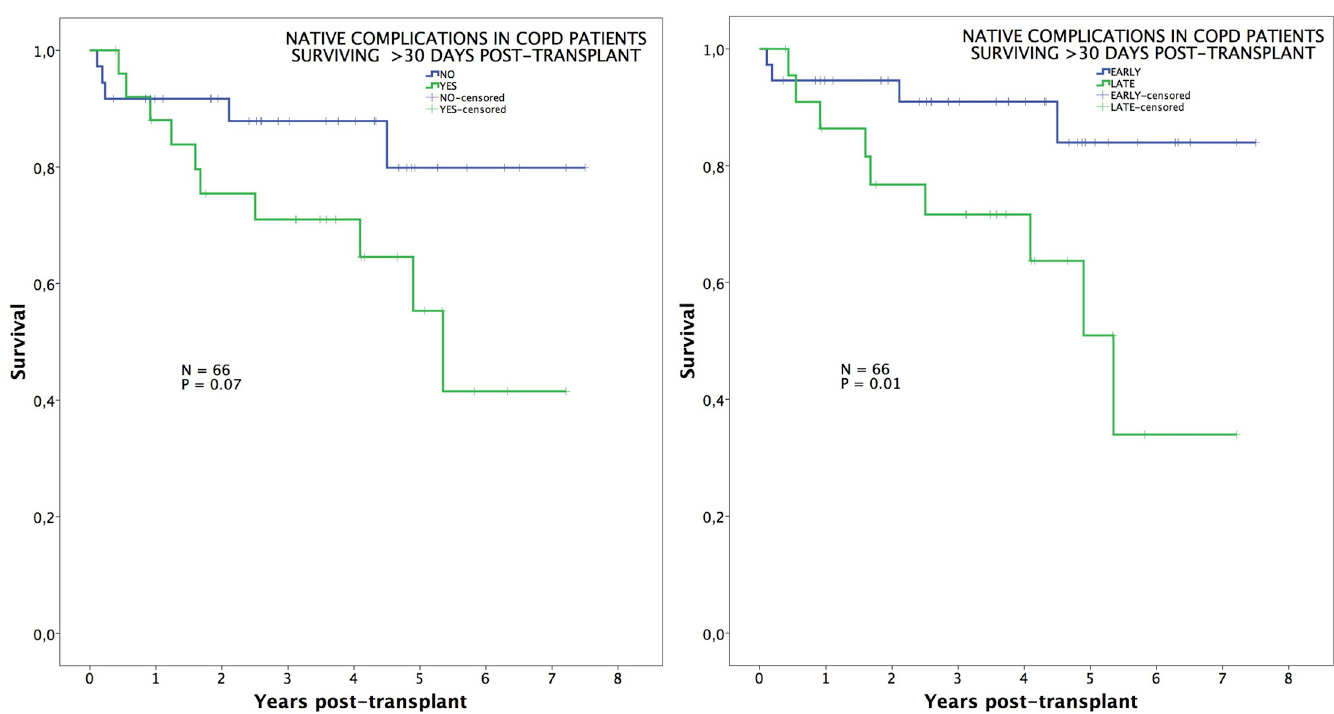
Fig 4. Survival in COPD patients conditional to survive 30 days. Post-transplant survival, conditional to survive 30 days, of COPD patients comparing those with or without native lung complications (left), and those with early or late native lung complications (right).